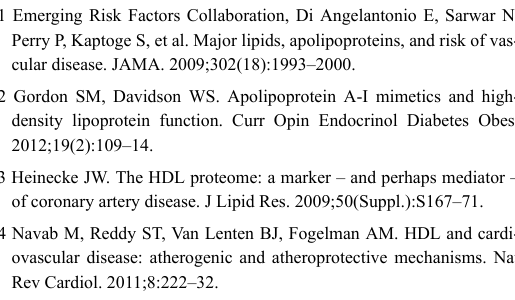
Table 2: Summary of apolipoprotein A1 (apoA-1) post-translational modifications leading to dysfunctional apoA-1. ApoA-1 modificatios